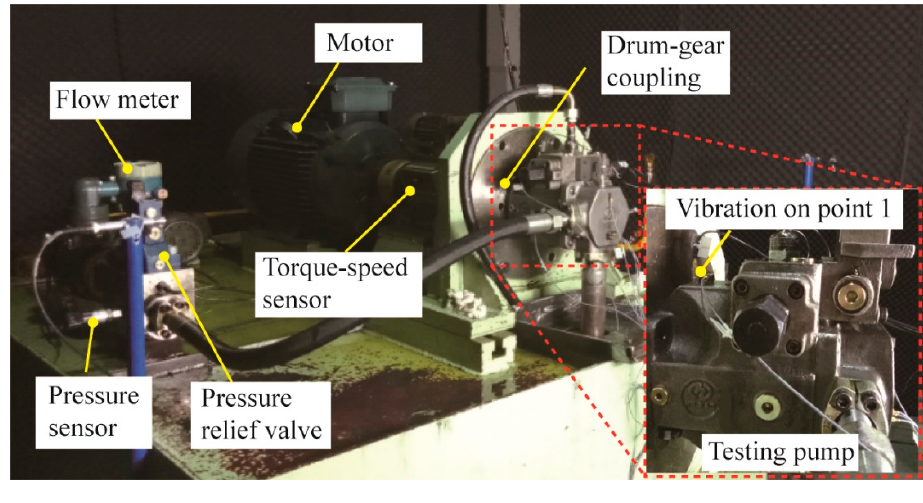
Figure 3. Layout of the test rig.